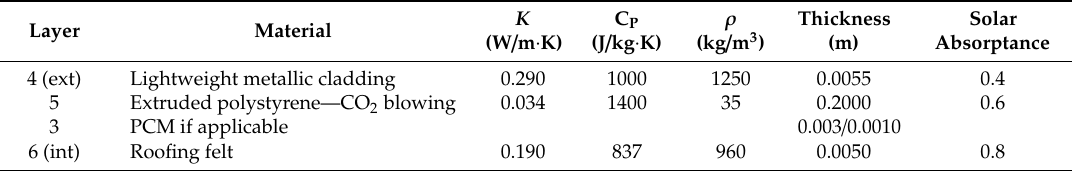
Table A1. Building materials for roof construction.